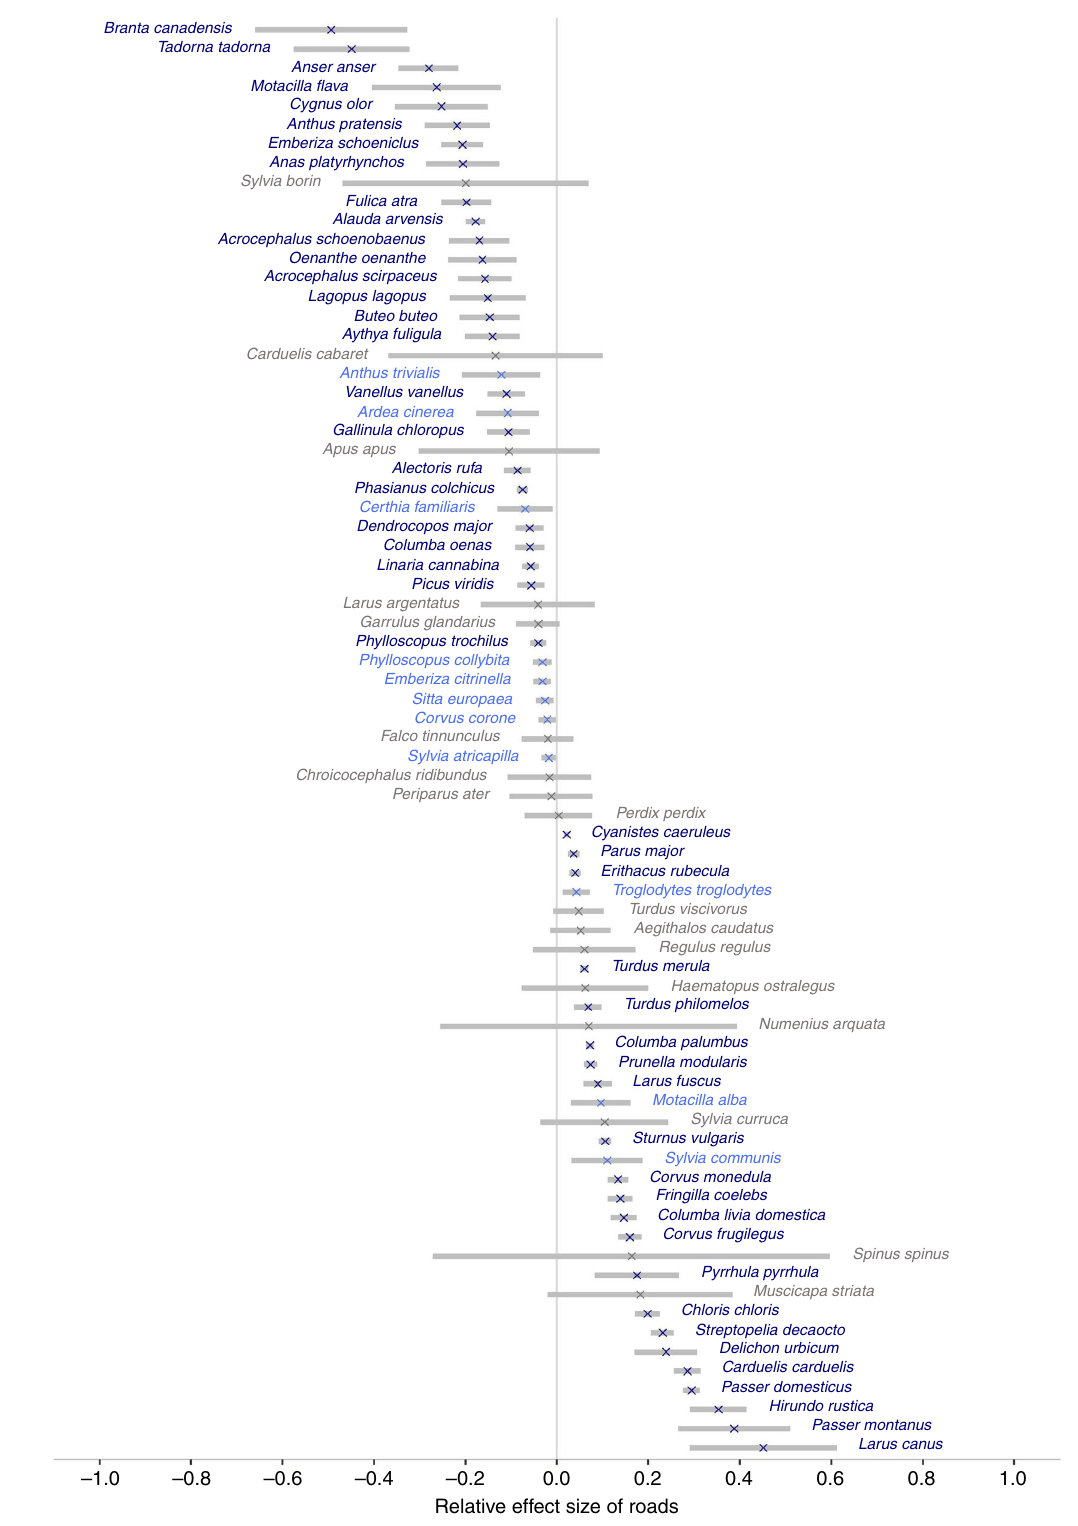
Fig. 1 Relative effect size of associations between road exposure and bird abundance. For each species, the relative effect size was calculated as a composite of the magnitude of the effect size of road exposure and the spatial scale over which the effect could be detected (the latter being determined by the parameter ‘ k ’ ). Species with signi fi cant associations, determined using a critical alpha level of 0.05, are labelled in blue, with those whose signi fi cant associations were retained after Bonferroni correction in dark blue. Grey bars depict 95% con fi dence